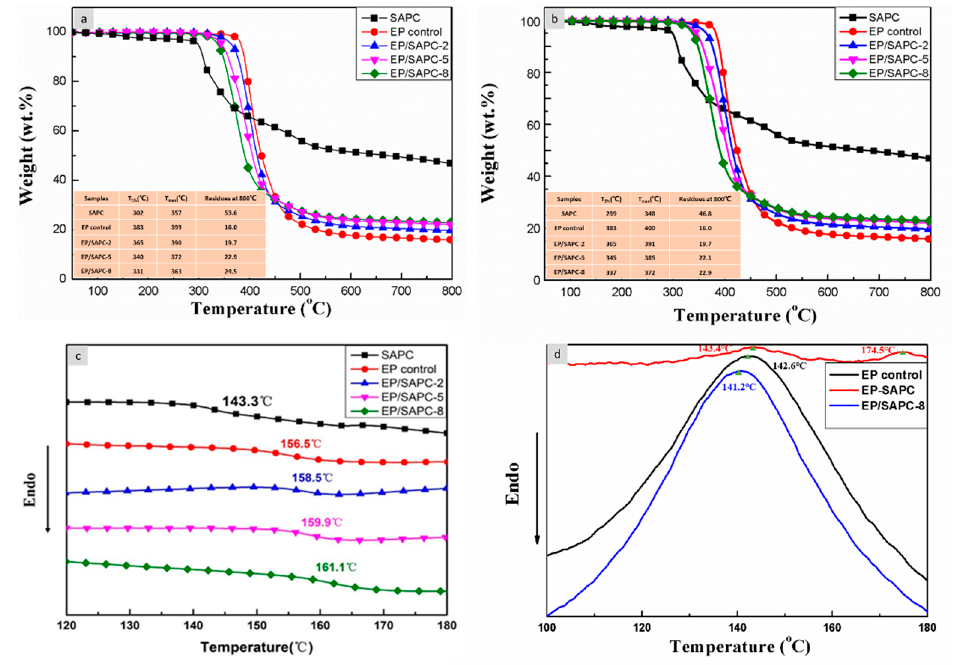
Figure 4. ( a ) Thermogravimetric analysis (TGA) curves under the nitrogen atmosphere; ( b ) TGA curves under the air atmosphere; ( c ) differential scanning calorimetry (DSC) curves; ( d ) DSC curves during curing process.